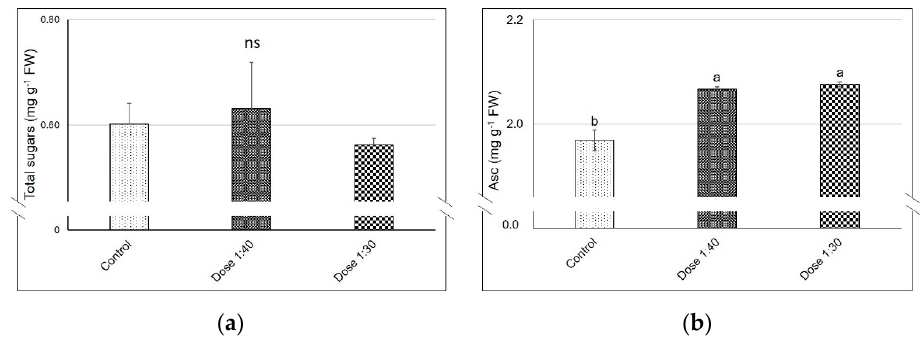
( c ) Figure 1. Effect of Moringa oleifera leaf extract (MLE) foliar application on the antioxidant activity ( a ) (DPPH, mg TE g − 1 FW), TPC ( b ) (mg GAE g − 1 FW), and total flavonoid content ( c ) (mg RU g − 1 FW) of radish baby leaf. Data are means ± standard error ( n = 3). Three biological replicates were used for the analysis. Different letters indicate significance at p < 0.05 according to Tukey’s test; ns, not